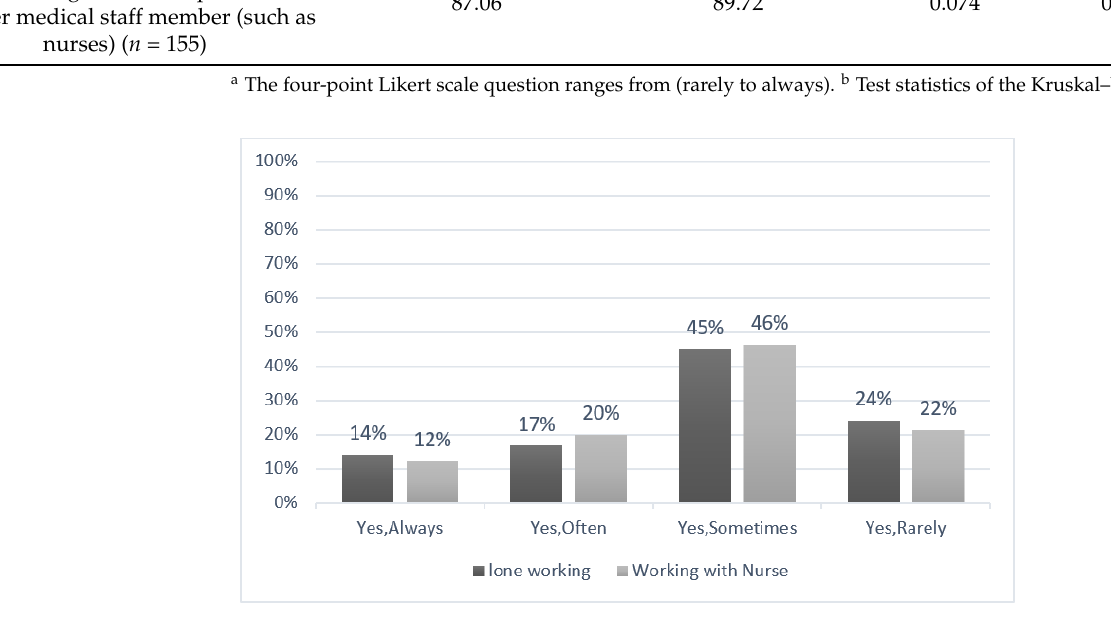
Figure 1. Relationship between days spent working alone and the frequency of working in the presence of another medical staff member.